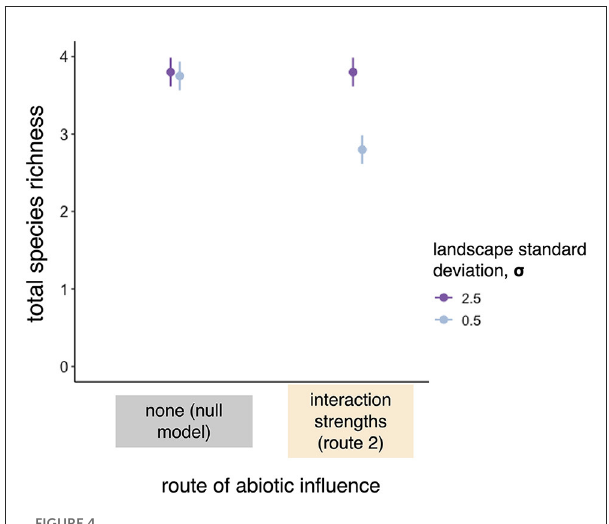
FIGURE4 When we reduced the landscape-level standard deviation of abiotic conditions from 2.5 to 0.5, total species richness at the landscape-scale remained high in null model simulations, but decreased when abiotic conditions determined interaction strengths (route 2). Simulations had intermediate dispersal and α ij = α ii = 1. Points and whiskers are the estimated marginal means and confidence intervals from a linear model (Supplementary Table